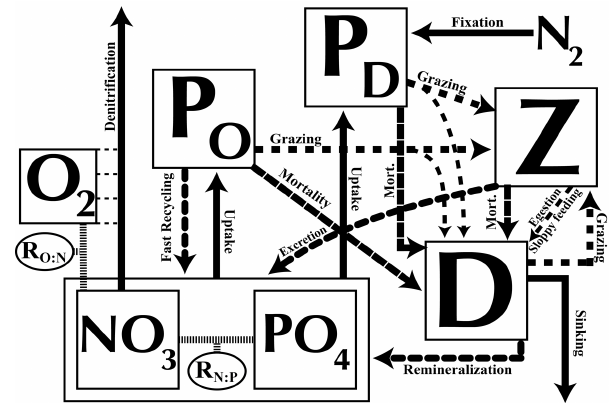
Figure 2 Fig. 1. Ecosystem model schematic which illustrates the flux (ar- rows) of material between model variables (squares). See text for a detailed description of these